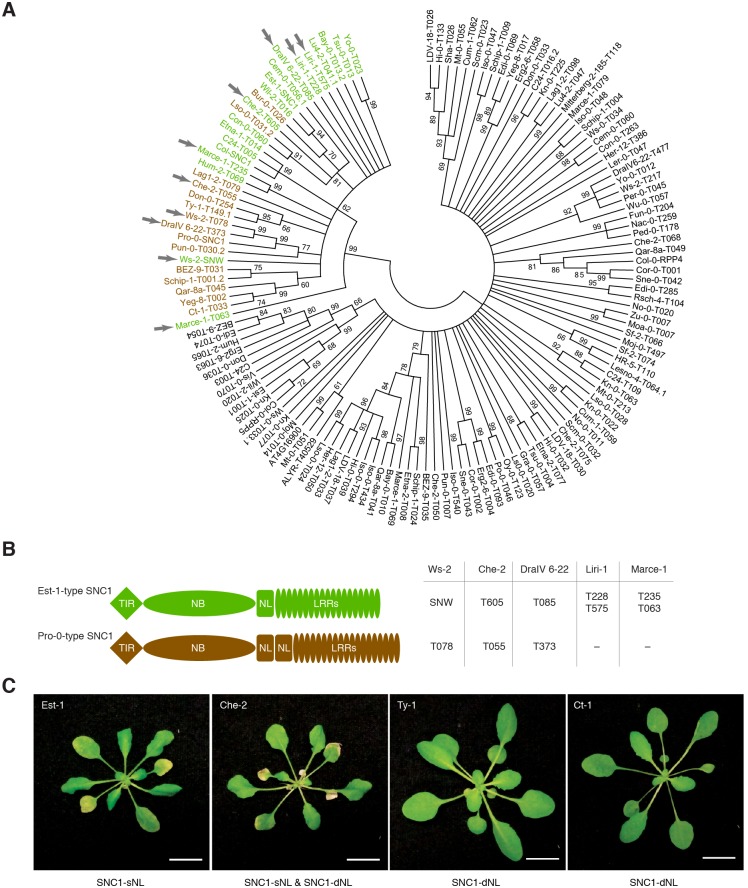
Correlation between SNC1 alleles and ACD6-Est-1 effects in natural accessions.(A) Phylogeny of 136 RPP4/5 and SNC1 proteins from 65 accessions. Bootstrap values over 60% are indicated. The SNC1 clade is highlighted in color, with single NL linker (SNC1-sNL) genes green and duplicated NL linker (SNC1-dNL) genes brown. Arrows highlight five accessions with two SNC1 homologs. (B) Diagrams of SNC1 proteins with single and duplicated NL linkers. Gene IDs for five accessions with two SNC1 homologs on the right. (C) Accessions with ACD6-Est-like alleles; SNC1 types indicated below. Scale bar, 10 mm.